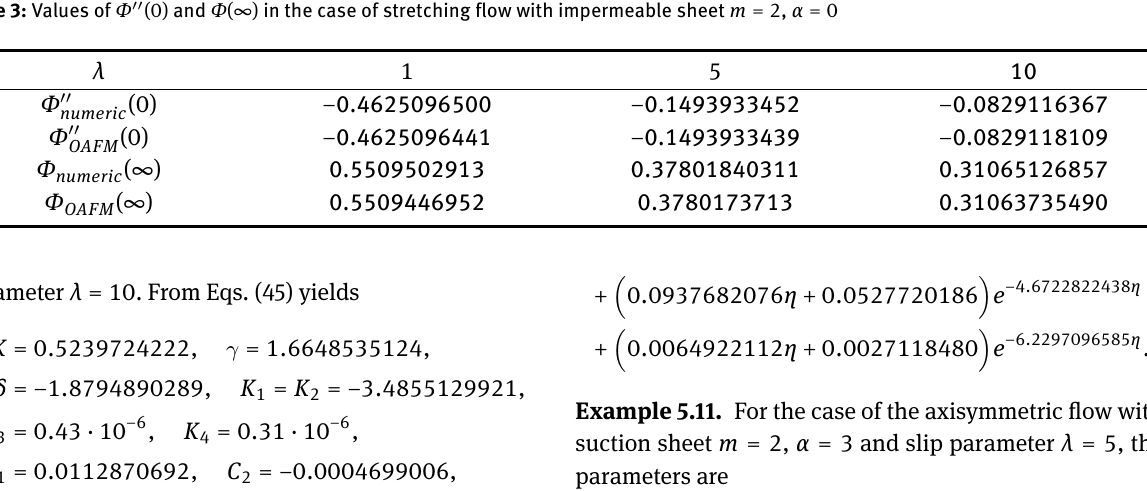
Table 3: Values of Φ ′′ (0) and Φ (∞) in the case of stretching flow with impermeable sheet m = 2 , α =